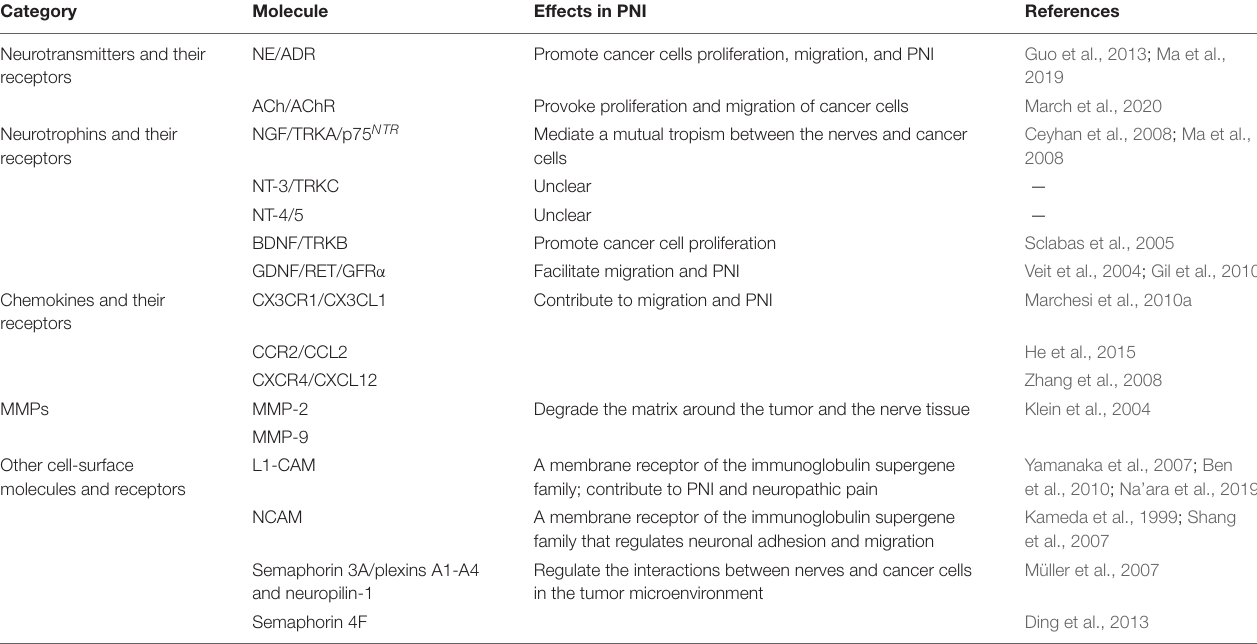
TABLE 1 | Molecular factors involved in perineural invasion